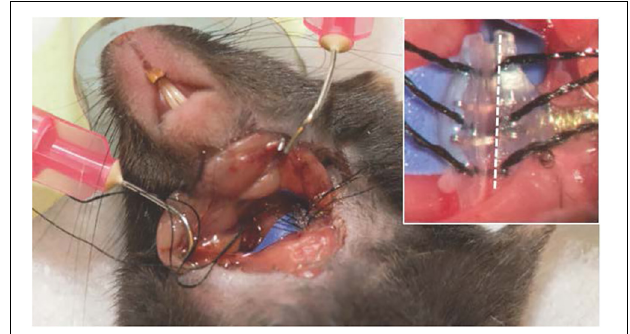
FIGURE 4 | Surgical preparation of the electrode implant. Close up (inset), where the white dotted line lies parallel to the nerve lying inside the cuff. All procedures described and animal photography was performed with approval by the Institutional Animal Care and Use Committee (IACUC) at the University of